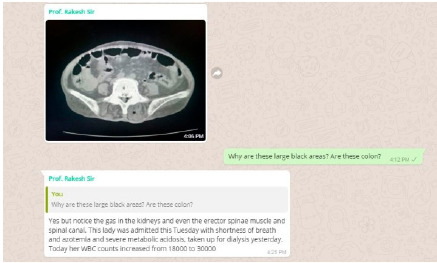
Figure 3. Illustrating the patient data shared online into our CBBLE online network.